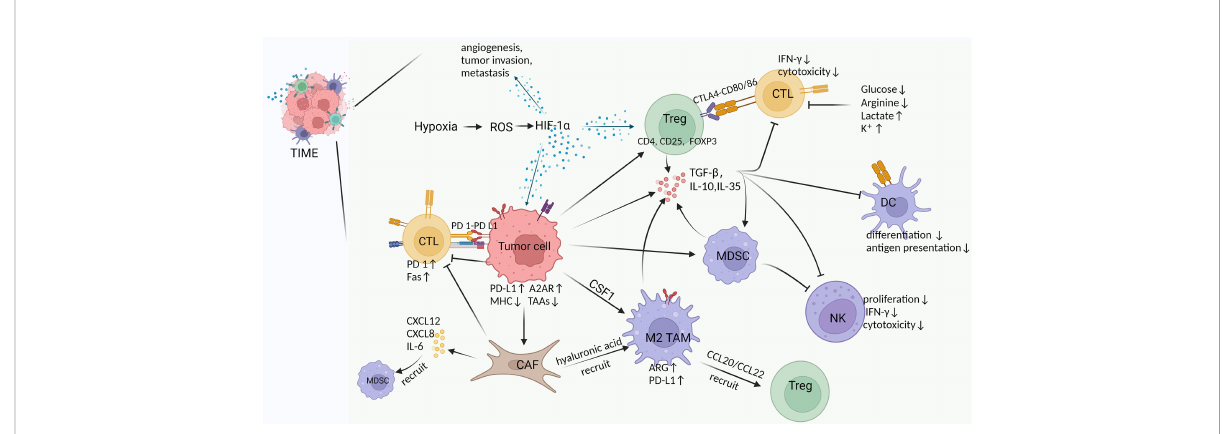
FIGURE 1 Cross-talk between various components in TIME. Hypoxia is an important feature of TIME in solid tumors, which exerts multiple effects by inducing HIF-1 a , such as 1) promoting angiogenesis, tumor invasion and metastasis, 2) increasing Tregs abundance to suppress host immune response, and 3) upregulating PD-L1 and A2AR on tumor cells to evade immunity (26 – 30). Tumor cells induce and chemotactic immunosuppressive cells (Tregs, M2 TAMs, MDSCs, CAFs) to in fi ltrate in TIME by secreting TGF- b and CSF (31, 32). Moreover, tumor cells inherently upregulate PD-L1 and A2AR expression to suppress the immune function of CTLs, as well as downregulate MHC and tumor- associated antigens (TAAs) expression to reduce antigen presentation and immune activation (29, 30). Tregs produce multiple immunosuppressive cytokines and express CTLA4 to inhibit CTLs and DCs by binding CD80/86 (33). M2 TAMs in TIME suppress T cell function by upregulating ARG and PD-L1 expression while recruiting Tregs via CCL20/CCL22 (34 – 36). MDSCs produce inhibitory cytokines and inhibit the formation and cytotoxicity of NK cells by reducing NKG2D expression and IFN- g secretion (37). CAFs secrete a large number of cytokines, chemokines and ECM, which exhibit immunosuppressive and tumor-supportive effects (31, 38, 39). For example, IL-6 from CAFs recruits MDSCs, CAFs reduce M1 macrophages while recruiting M2 TAMs via hyaluronic acid, upregulated expression of Fas and PD-1 suppresses and depletes T cells (40 – 42). Suppressive cytokines (e.g., TGF- b , IL-10, IL-35) can be produced by tumor cells and a variety of immunosuppressive cells in TIME to inhibit immune killing of CTLs, suppress the differentiation and antigen presentation of DCs, and restrain the proliferation and cytotoxicity of NK cells (43 – 46). In addition, glucose and arginine de fi ciency in TIME, as well as high lactate levels inhibit T cell function (47 –